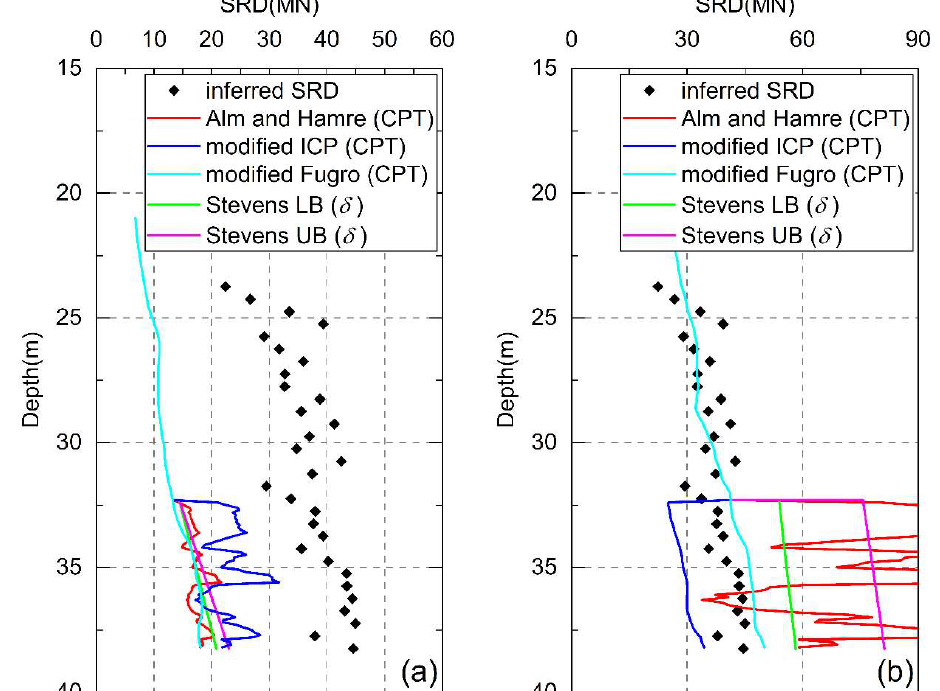
Figure 9. Comparison of SRD between inferred and calculated values (for sand) ( a ) cored pile; ( b ) fully plugged pile.